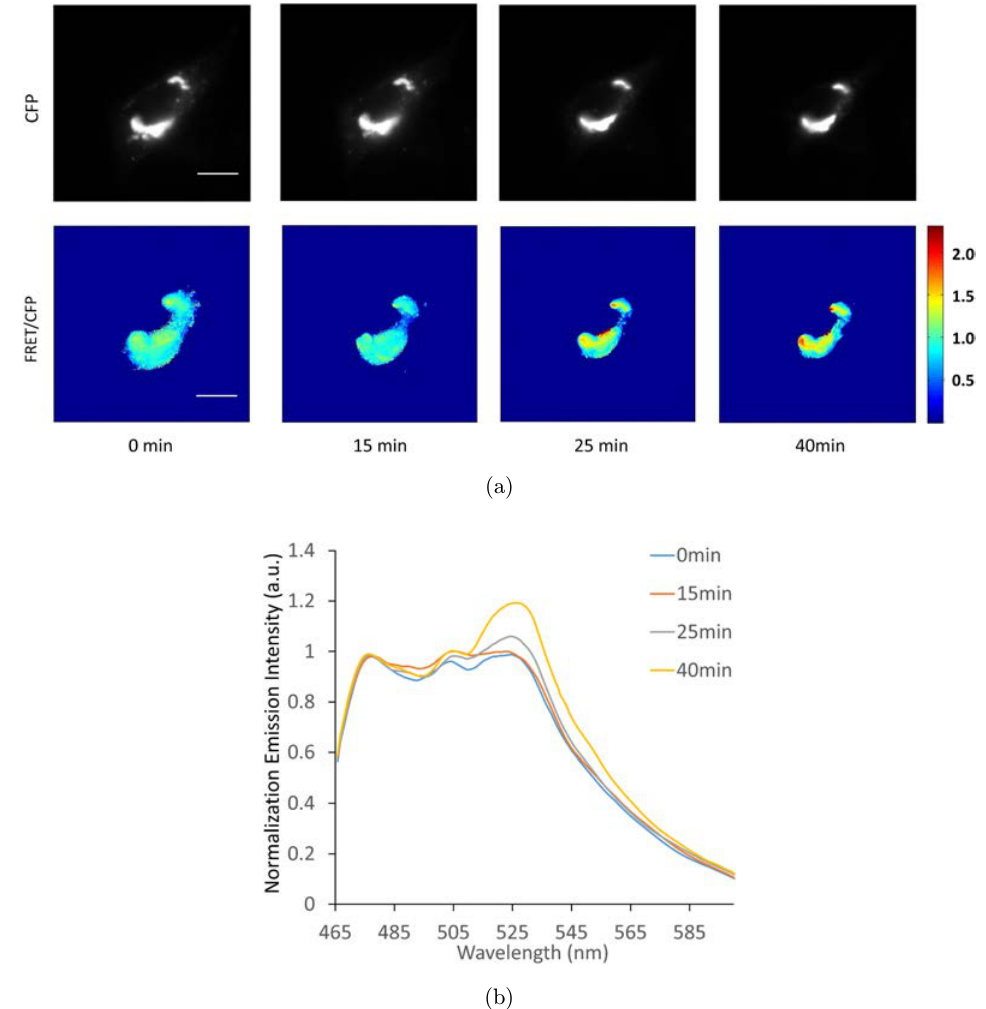
Fig. 5. Analysis of LMP1/LMP1 interaction by FRET method. FRET was measured in CNE1 cells co-expressing the LMP1-CFP and LMP1-YFP fusion proteins as described in materials and methods. (a) FRET images. The pseudo-color images depicted FRET e±ciency, calculated as FRET/CFP ratio, with the color indicating the relative value at each pixel. (b) FRET °uorescence spectra. Images and °uorescence spectra were representative of three independent experiments. Scale bar, 10 (cid:2)